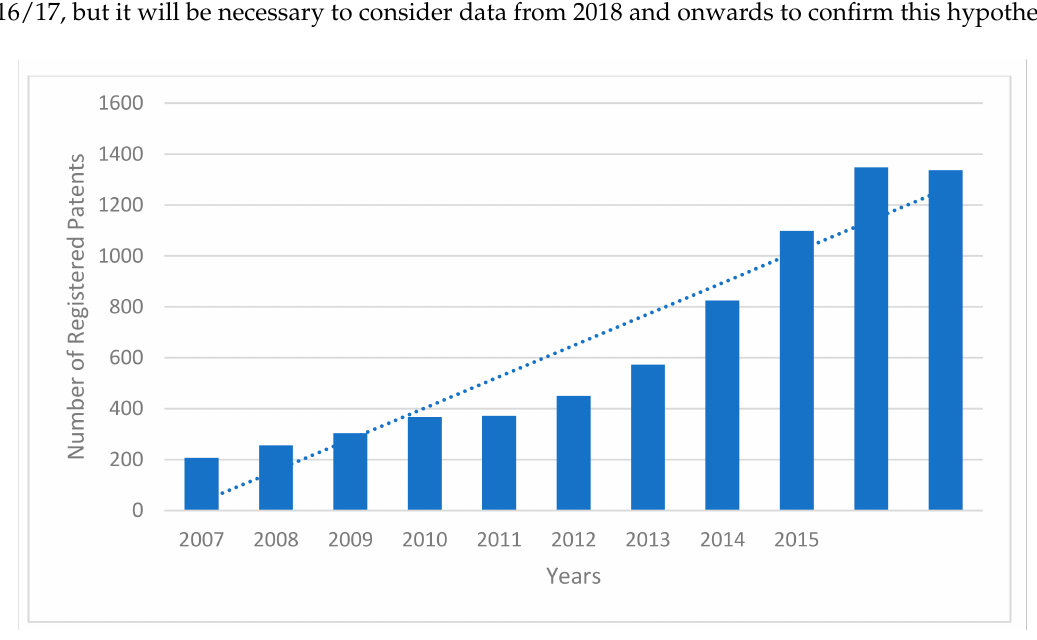
Figure 4. Trend analysis of yearly number of patent registrations involving antimicrobial silver applications over the past